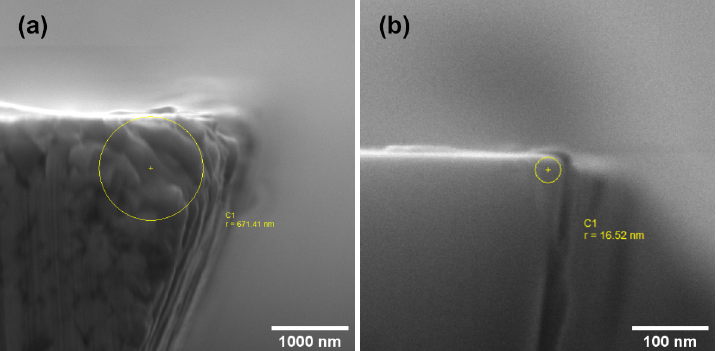
Figure 5. SEM-images of the cutting edge radius, taken parallel to the tool axis. ( a ) SC-tool. ( b ) MD-tool.